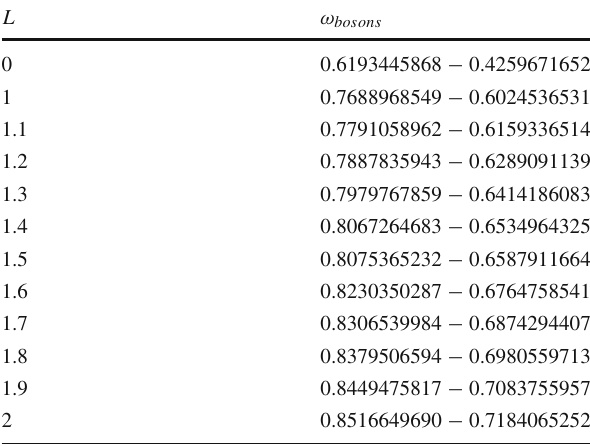
Table 1 QNMs of scalar waves in the slowly rotating Kerr-like black hole spacetime